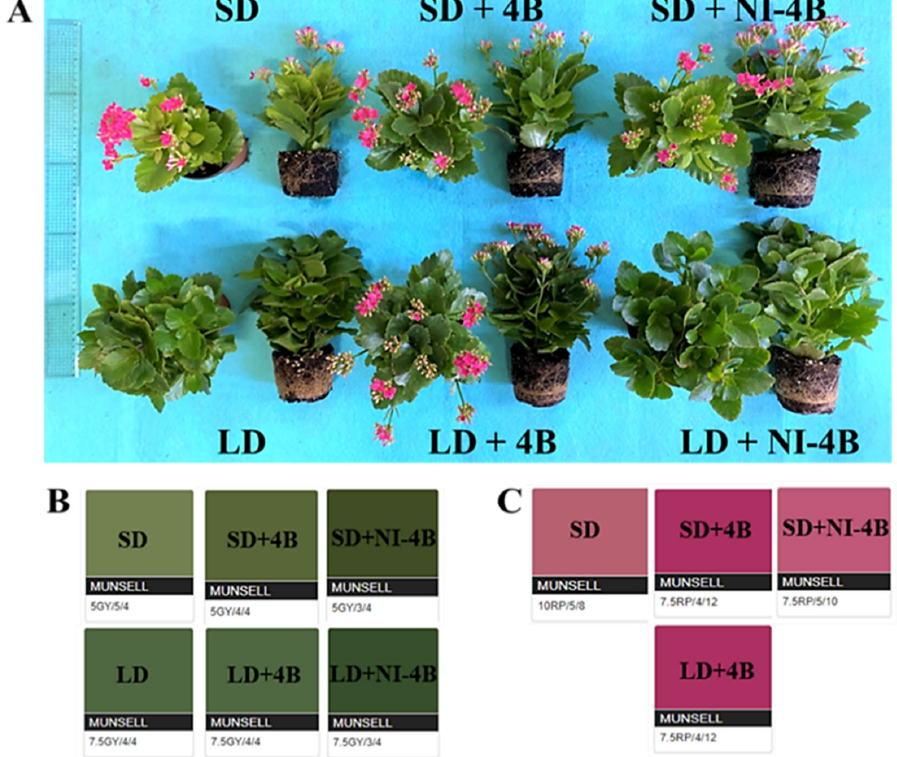
Figure 3. The effects of the supplementary and night ‐ interrupting 10 μ mol ∙ m − 2 ∙ s − 1 PPFD B light on the flowering of kalanchoe ( Kalanchoe blossfeldiana ‘Rudak’), after 60 days of exposure to the photoperiodic light treatments: The morphology ( A ); leaf color charts ( B ); and flower color charts ( C ) [The color charts of leaves and flowers were analyzed by ‘Munsell Colortell System’; e.g., in ‘5GY/5/4’, ‘5GY’ indicates ‘hue’, ‘5’ indicates ‘value’ (the larger the value, the lighter the color), and ‘4’ indicates ‘chroma’ (the larger the value, the brighter the color)] (See Figure 2 for details on the photoperiodic treatments with B light).